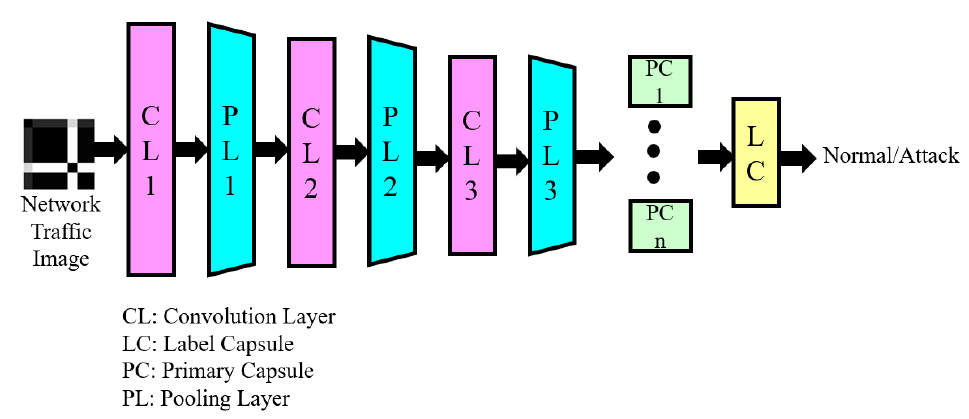
Figure 5. Block schematic of proposed capsule